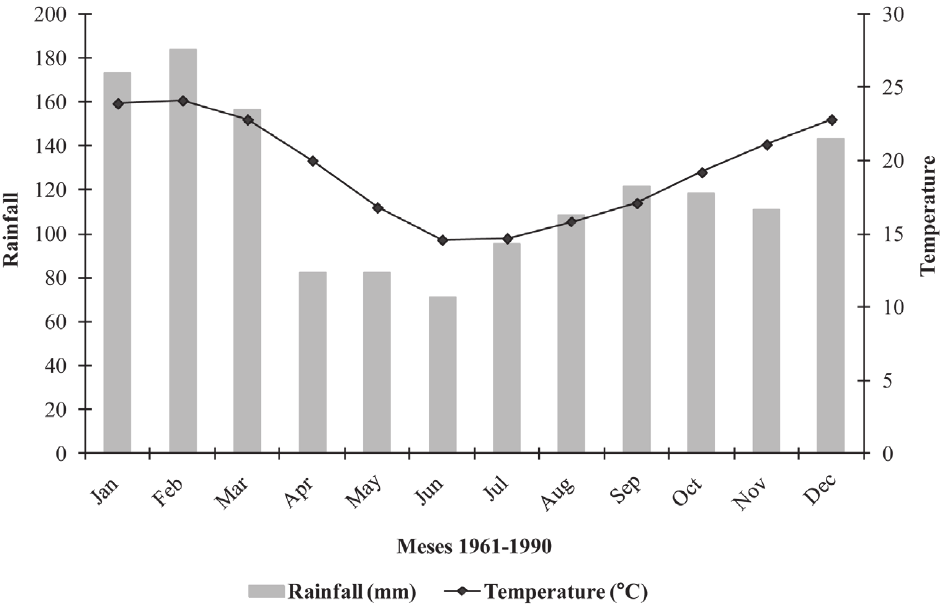
Fig. 1 - Climatic diagram of the municipality of Orleans over a period of 30 years